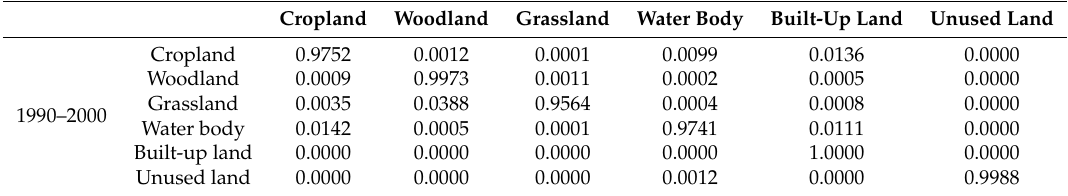
Table 3. Land-use transition possibilities, 1990–2000.